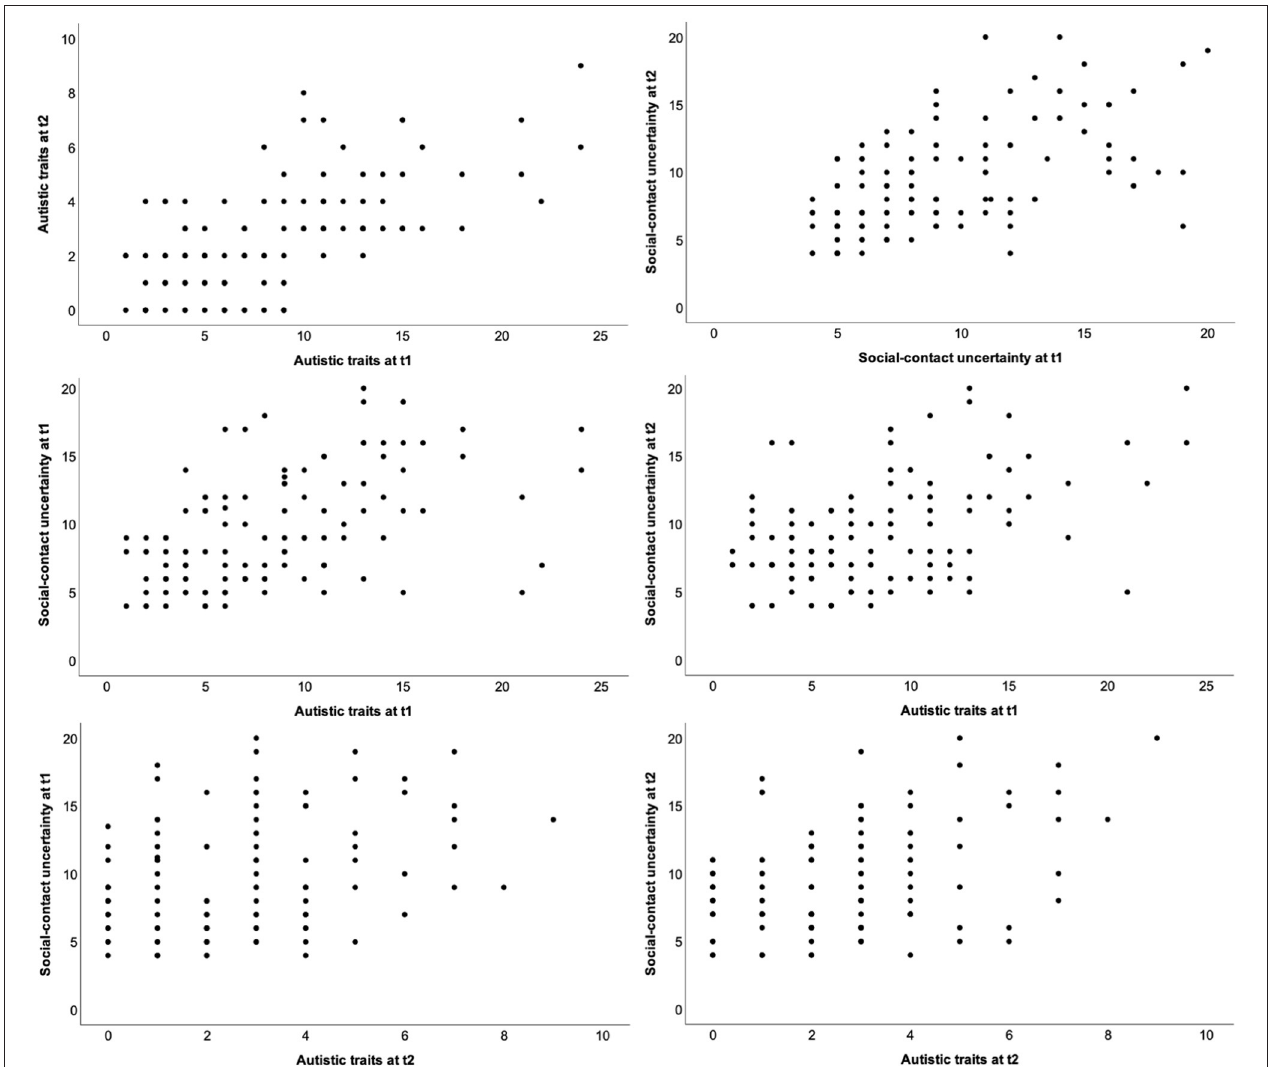
FIGURE 1 | Scatterplots for the intercorrelations of autistic traits and social-contact uncertainty at both times of measurement.